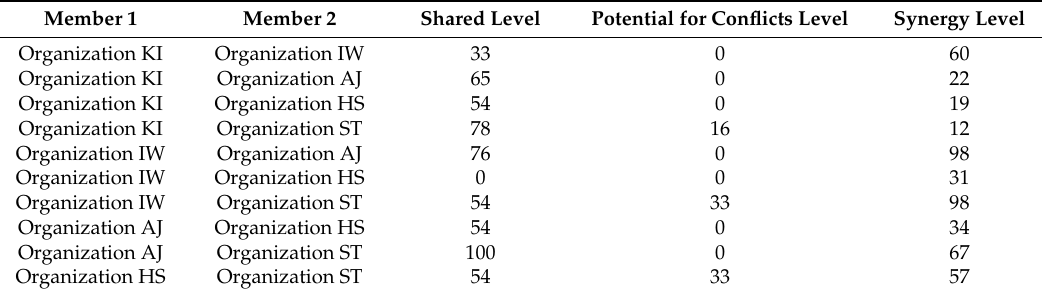
Table 6. Detailed Results for Potential Consortium